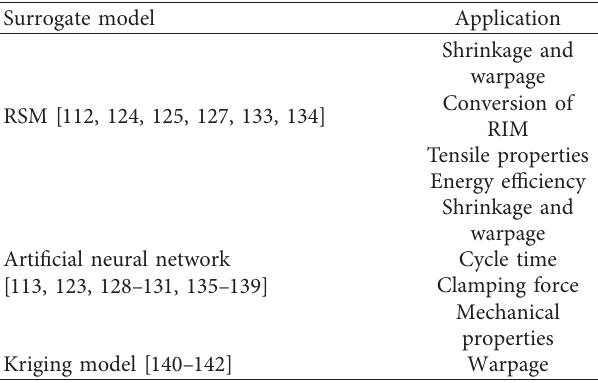
Table 2: A survey of surrogate models for injection molding